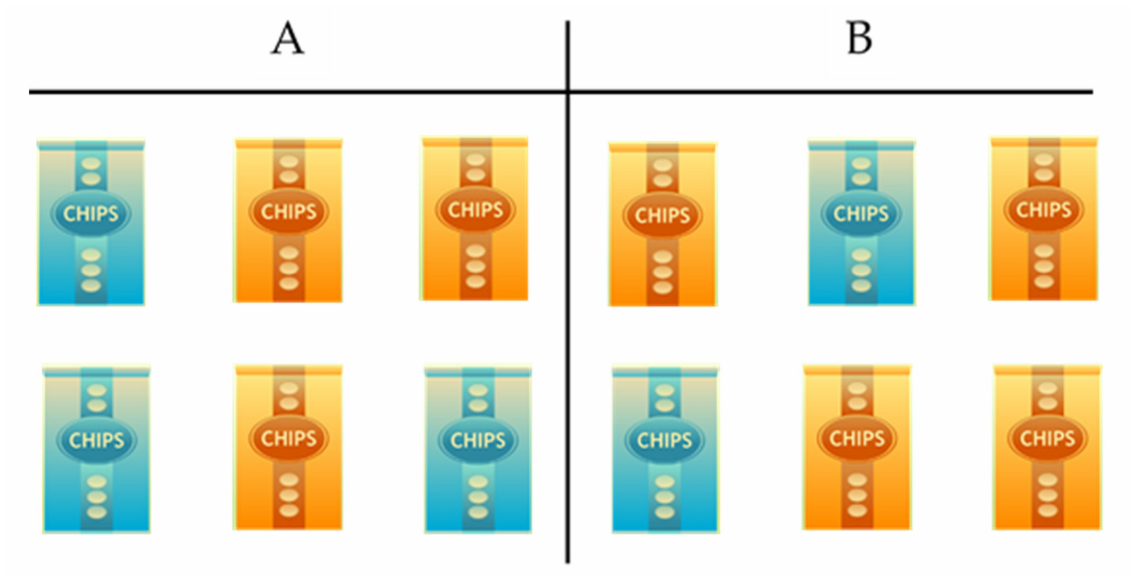
Figure 1. An illustrative example of the food choice task. Selection ( A ) demonstrates the even condition with a balanced distribution of ≥ 199 kcal (shown here in blue) and ≤ 99 kcal snacks (depicted in orange) ( B ) illustrates the uneven condition, whereby there was a 4:2 ratio in favour of the lower calorie snacks. Images are used for illustrative purposes only (adapted from: https://pixabay.com/illustrations/supermarket-shelf-products-snacks-1094815/ (accessed on 12 January